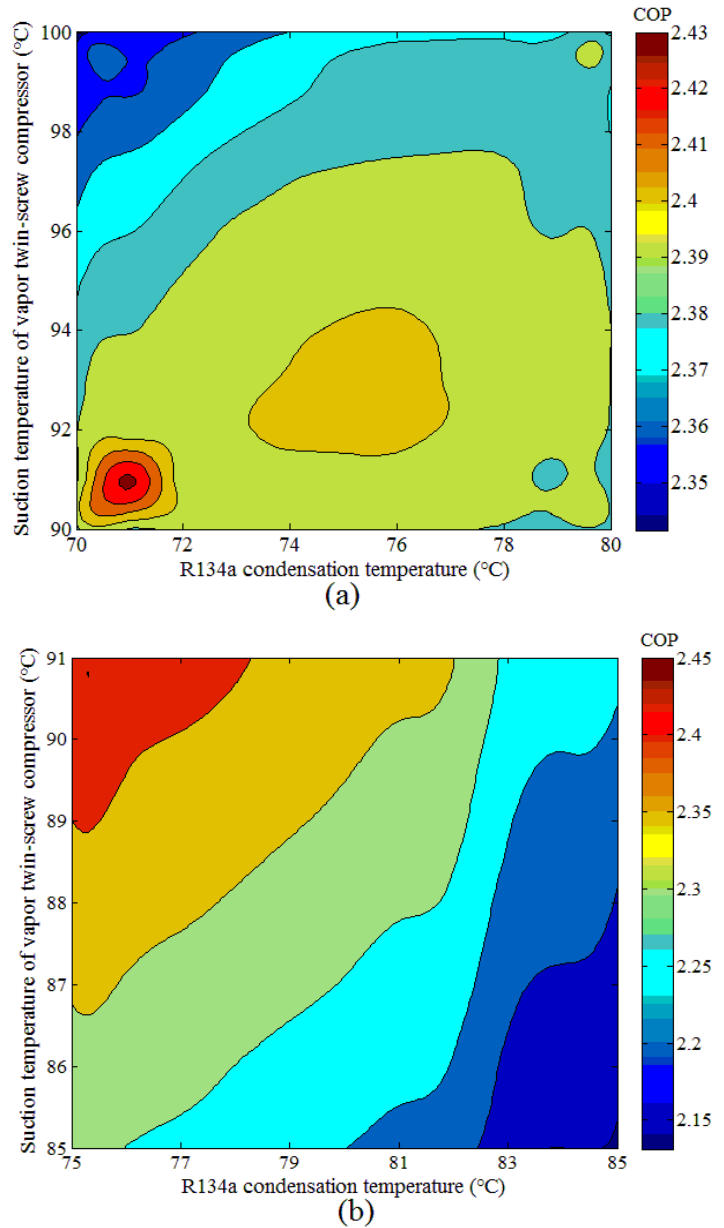
Figure 8. COP versus the R134a condensation temperature and the suction temperature of the vapor twin-screw compressor ( a ) CHPTV; ( b ) HPTVC. twin-screw compressor ( a ) CHPTV; ( b )